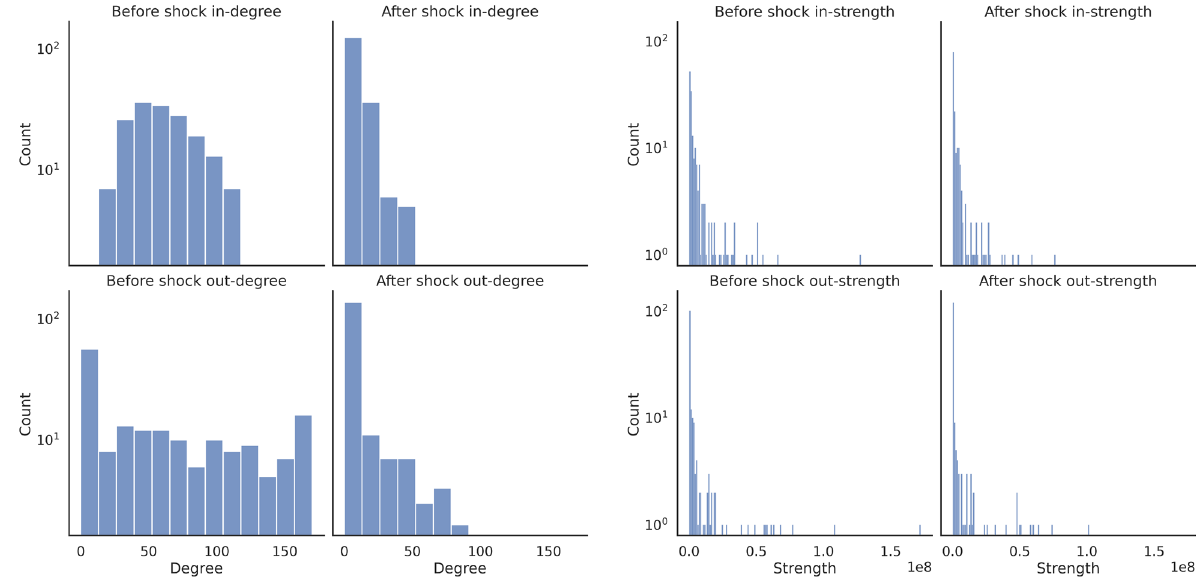
Figure 5. Diffusion of shock hitting the US: degree (left panel) and strength (right panel) distributions before and after the